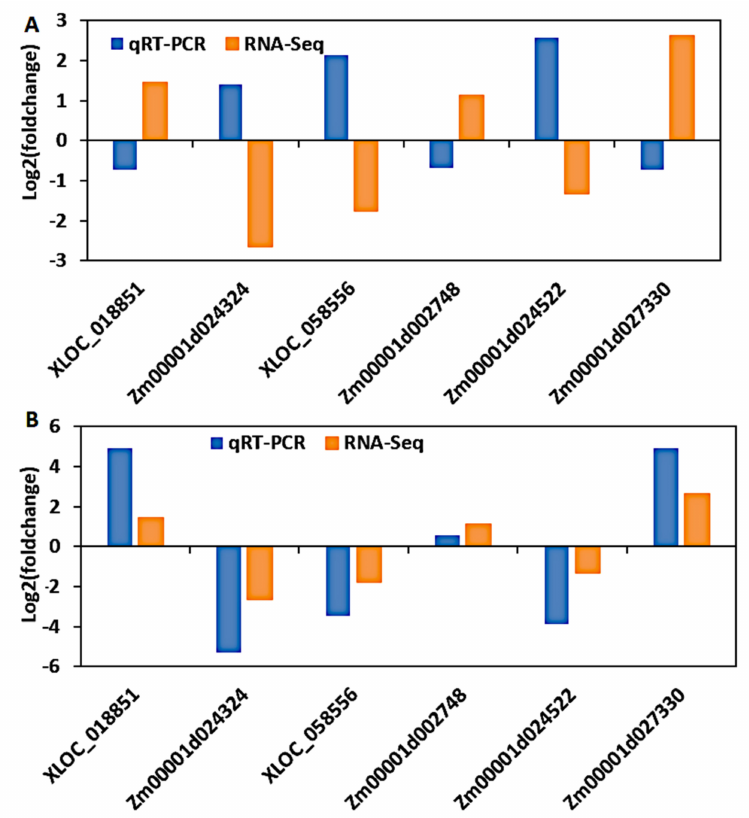
Figure 10. Validation of RNA-Seq results by qRT-PCR. Each log2 fold change calculated from qRT- PCR was compared with the log2 fold change of the RNA-Seq data. ( A ) The inverse expression patterns of the RNA-Seq and qRT-PCR results from the cold-sensitive line (B73) is because the fold change ratio highlighted in this study emphasizes the expression pattern in cold-tolerant lines. However, if you take the inverse of that fold change ratio, which will highlight the expression pattern in cold-sensitive lines, then the RNA-Seq and qRT-PCR expression trends would be identical. ( B ) The cold-tolerant line’s (CIMBL116) RNA-Seq and qRT-PCR results show a similar expression trend. Orange and blue bars represent RNA-Seq and qRT-PCR data,